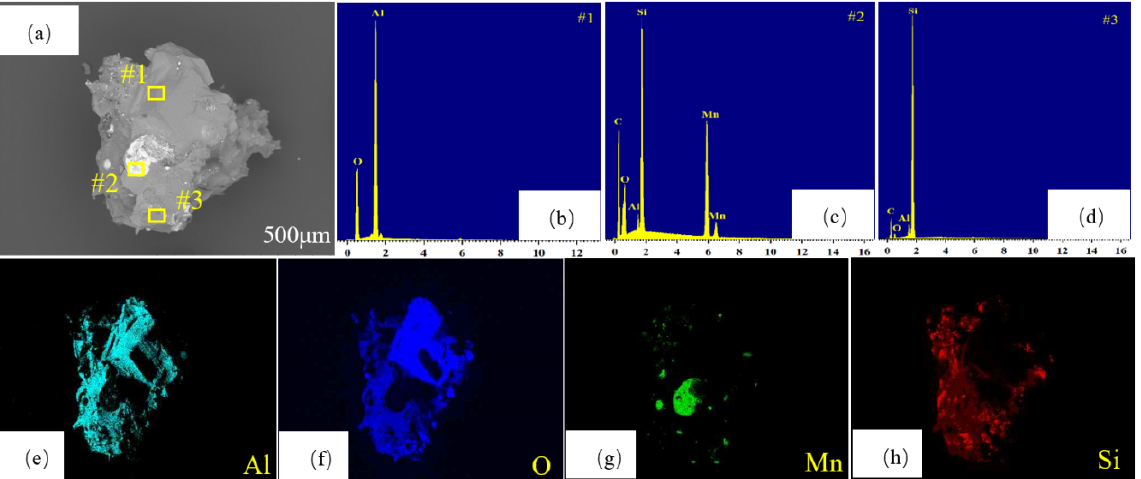
Figure 14. SEM-EDS image of the upper layer at 1873 K and 6 h: ( a ) SEM image; ( b ) #1 point scan; ( c ) #2 point scan; ( d ) #3 point scan; ( e ) Al element distribution; ( f ) O element distribution; ( g ) Mn element distribution; ( h ) Si element distribution.